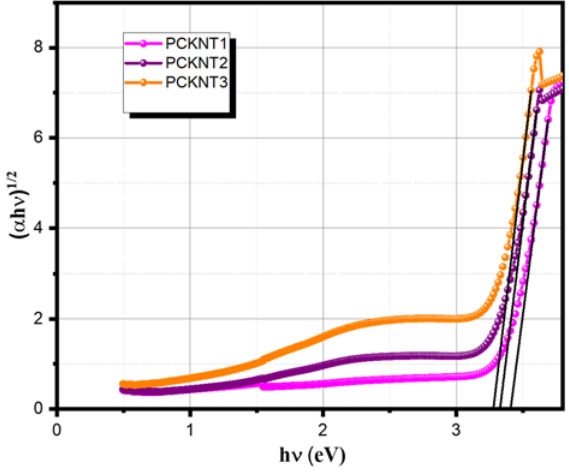
Figure 3. Plot of ( α hv) 1/2 as a function of the photon energy (hv) of prepared glasses.